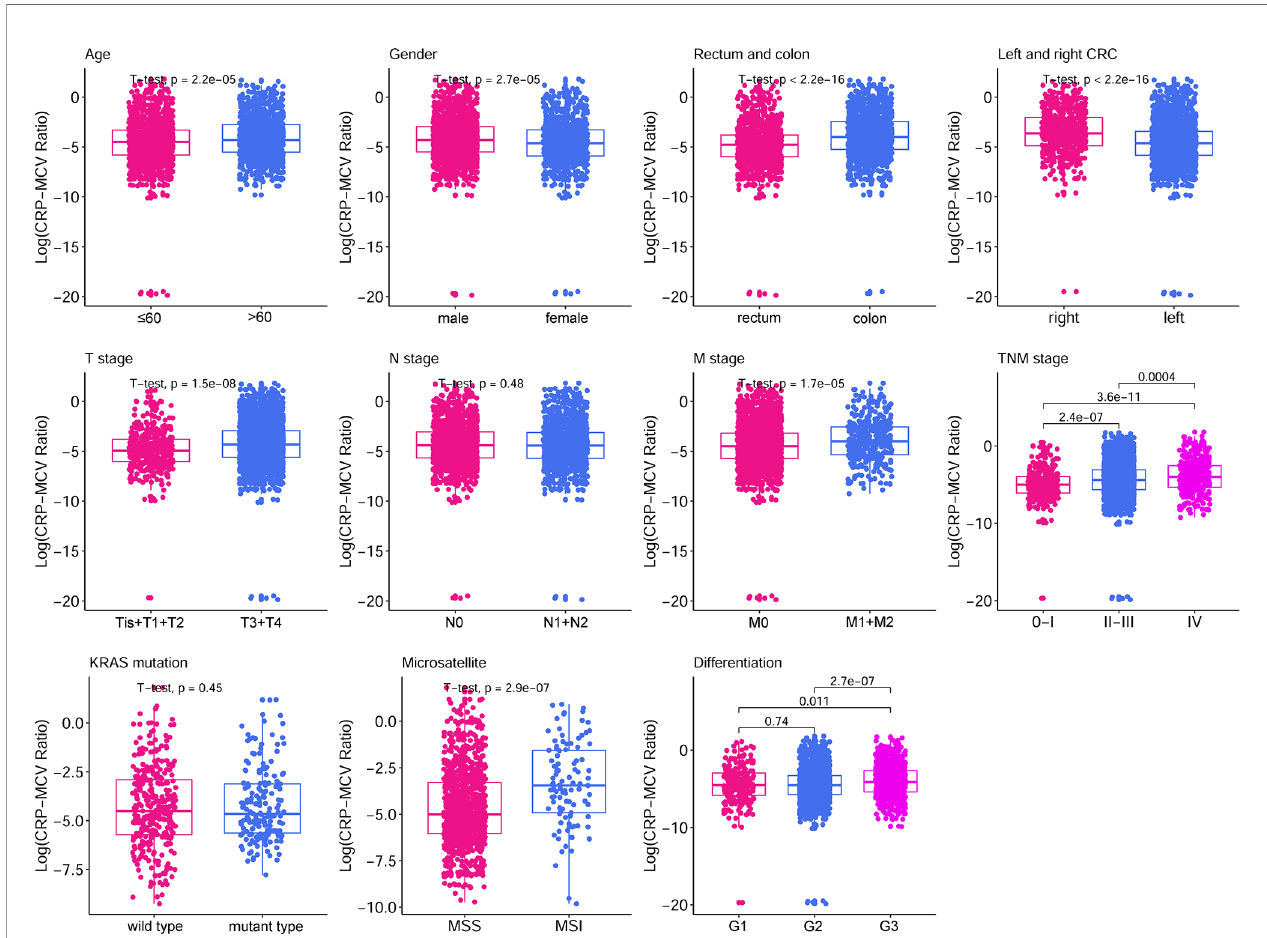
FIGURE 1 | Box plot of clinicopathological features based on CRP/MCV classi fi cation. The boxplots show the 5% and 95% con fi dence intervals. The box plot lower extreme is the fi rst quartile, and the box plot upper extreme is the third quartile. Box plots show the median and whiskers are the minimum and maximum, respectively. Elevated median levels indicated a higher CRP/MCV ratio. The statistical method used for each group was the Student ’ s t-test. CRP, C-reactive protein; MCV, mean corpuscular